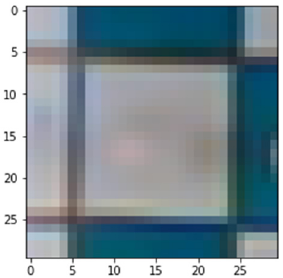
Figure 8. Example of white piece on a white background.